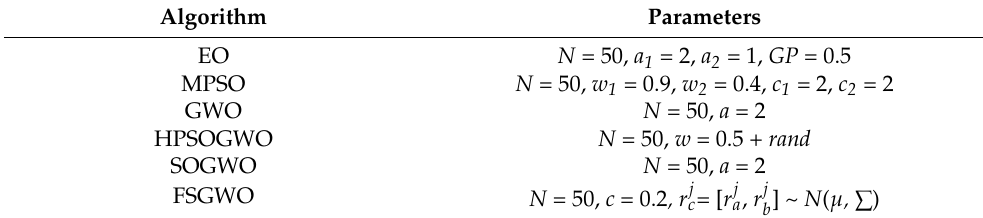
Table 1. Key parameters of the competitive algorithms.